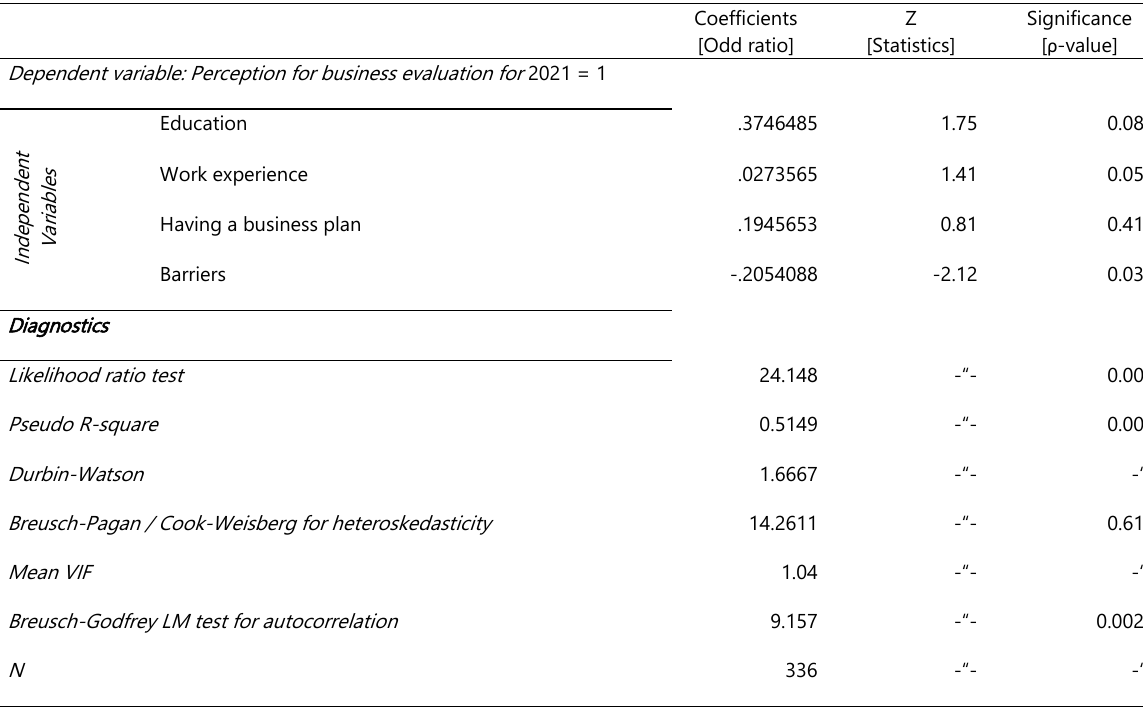
Table 4: Parameter Estimates (Source: Authors‟ calculation)